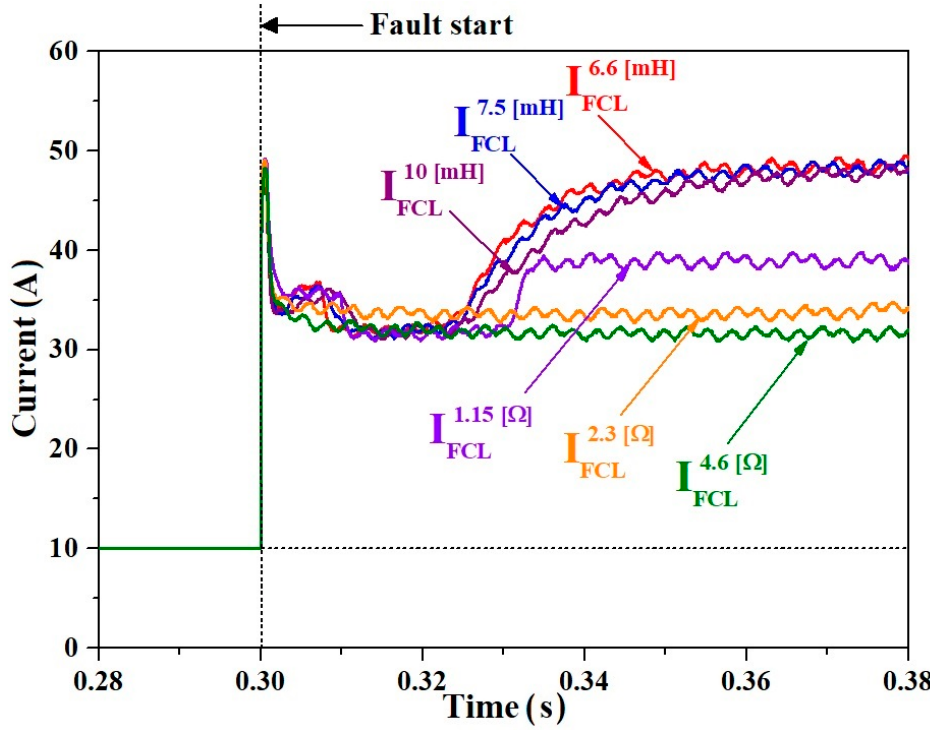
Figure 10. Comparative DC fault current waveforms of the DC SFCL using a transformer dependent on the CLR’s component.